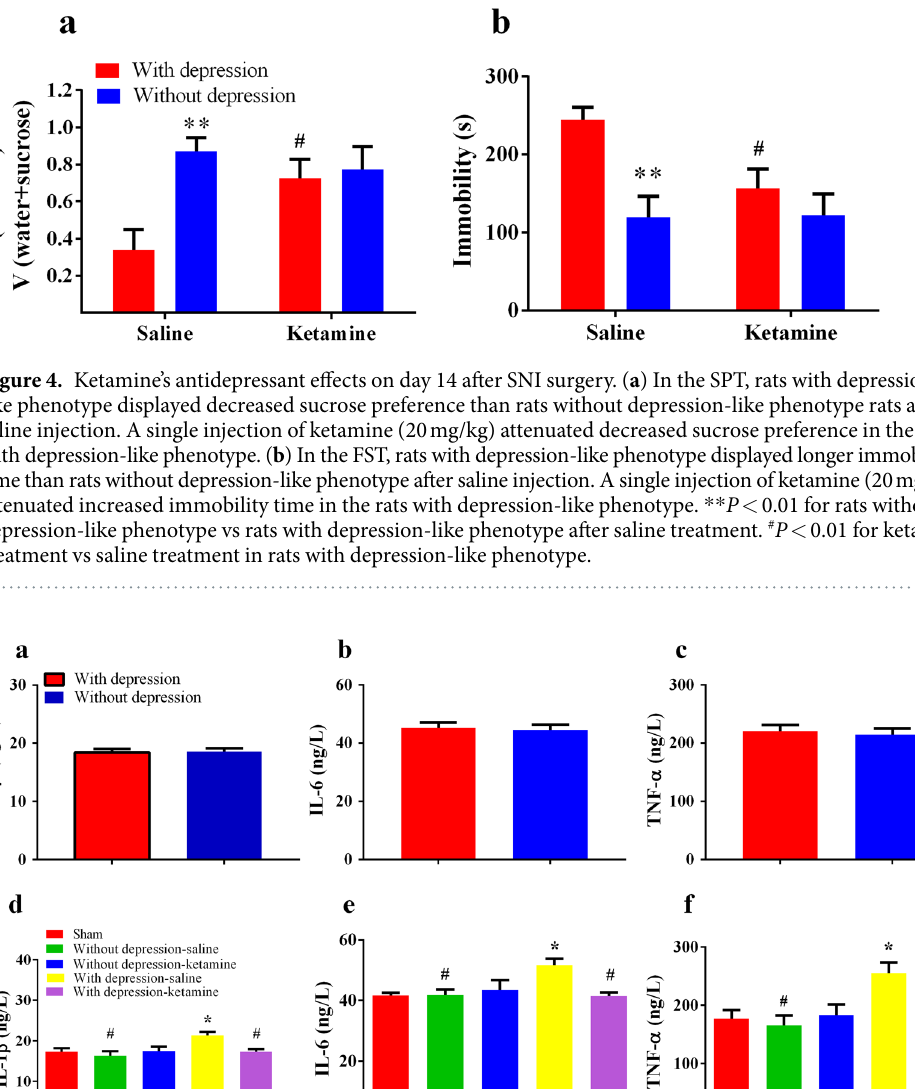
Role of serum cytokines in ketamine’s antidepressant efficacy. There were no differences of serum baseline cytokines between rats with or without depression-like phenotype (Fig. 5a–c). To determine the role of serum cytokines in antidepressant effect of ketamine, we measured serum levels of cytokines IL-1 β , IL-6 and TNF- α 3 days after a single dose of ketamine (20 mg/kg). Rats with depression-like phenotype showed higher serum levels of IL-1 β , IL-6 and TNF- α compared with sham-operated group ( P < 0.05, Fig. 5d–f). Furthermore, ketamine could decrease serum levels of IL-1 β and IL-6 in rats with depression-like phenotype compared with saline treatment ( P < 0.05, Fig. 5d,e). Rats with depression-like phenotype displayed higher serum levels of IL-1 β , IL-6 and TNF- α than rats without depression-like phenotype ( P < 0.05, Fig. 5d–f). To determine the ketamine’s response in rats with depression-like phenotype, discrimination analysis was applied to differentiate between responder group and non-responder group. Three of 8 rats with depression-like phenotype were classified as “non-responder group”, and the other 5 rats were regarded as “responder group”. Responder group displayed increased sucrose preference in the SPT ( P < 0.001) and decreased immobility time